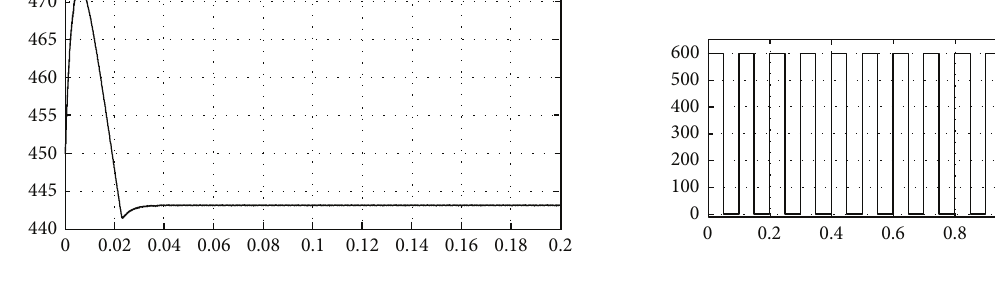
Figure 20: Control signals of switches 𝑆 1 and 𝑆 2 .